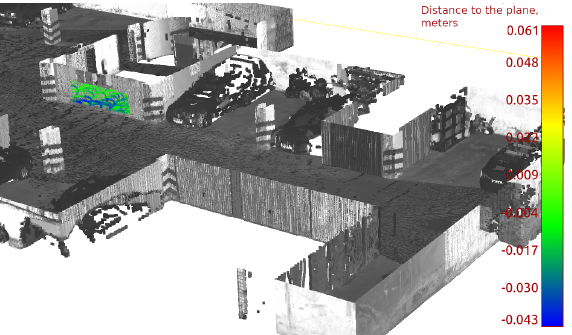
Figure 4. Example of planar feature. Gray scale: data from TLS. The color point cloud is the observation of the feature from the presented system. The color map shows the distance to the planar feature. Table 1. The normal distribution parameter of distances to fitted planar features. Each row is one feature, and each column one parameter. N ( µ tls , σ tls ) is the normal distribution approximation of distances’ distribution of points to planar features for TLS. N ( µ livox , σ livox ) is the normal distribution approximation of distances’ distribution of points to planar features for the system with rotated reflector. The last row consists of distributions’ parameters for all points and all features.